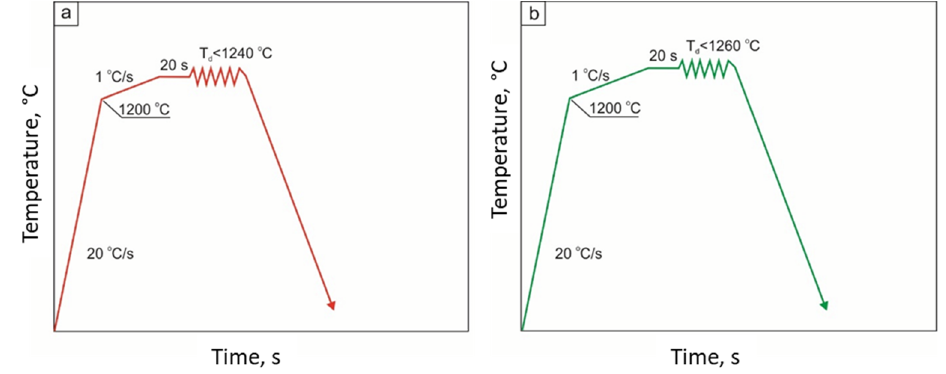
Figure 2. Scheme of determining the nil ductility temperature (NDT) in 27Mn-4Si-2Al-Nb steel ( a ) and in 24Mn-3Si-1.5Al-Nb-Ti steel ( b ).